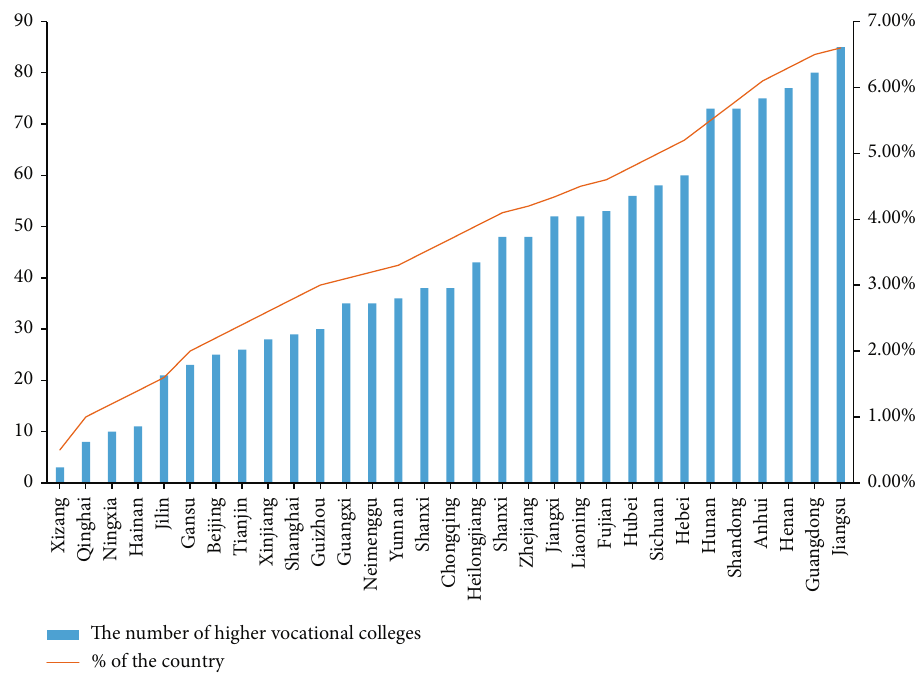
Figure 1: The development of national higher vocational